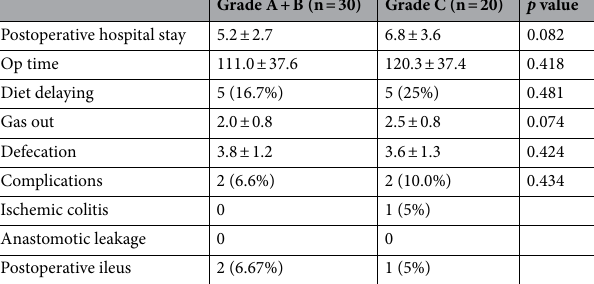
Table 6. Postoperative outcomes associated with perfusion according to grade (A + B vs.